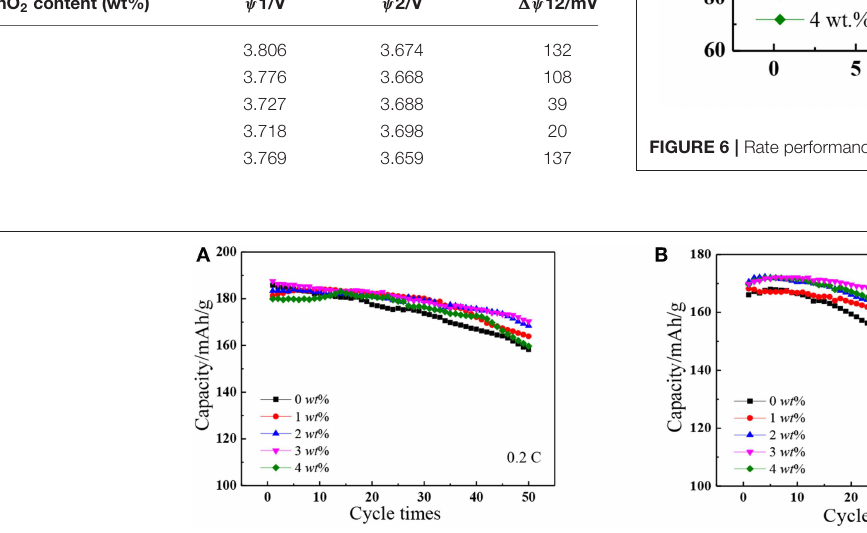
Frontiers in Energy Research |